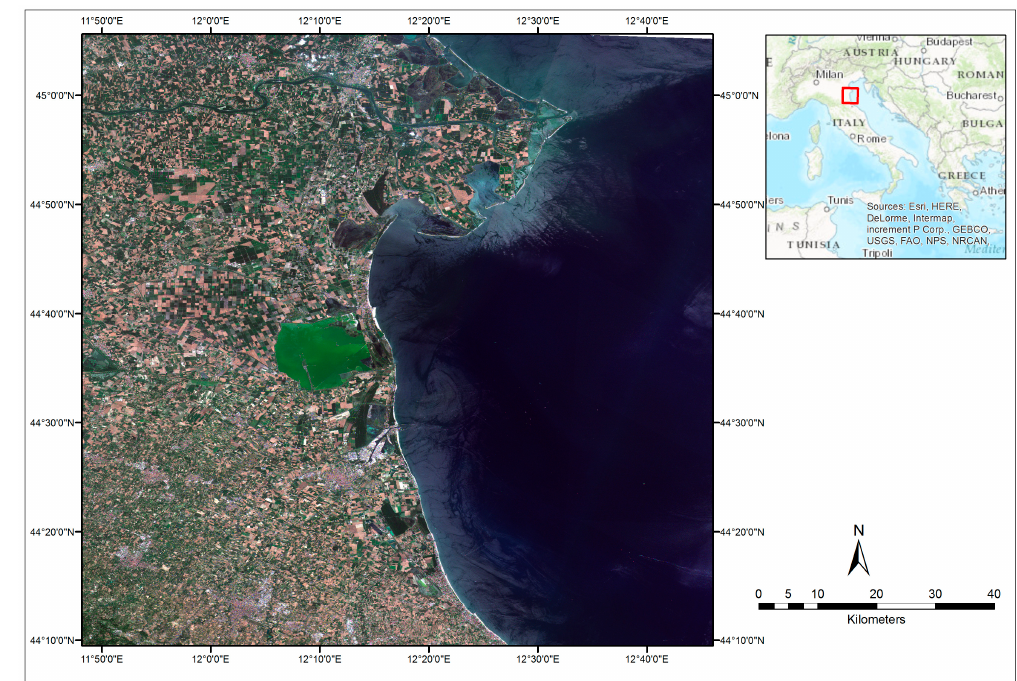
Figure 2. True color composite of Sentinel-2 image (Red: Band 3, Green: Band 2, Blue: Band 1) acquired on 8 July 2015 and covering the Po Delta on the Adriatic Sea, northeast (central coordinates: 12°13 ′ E, 44°35 ′ N).